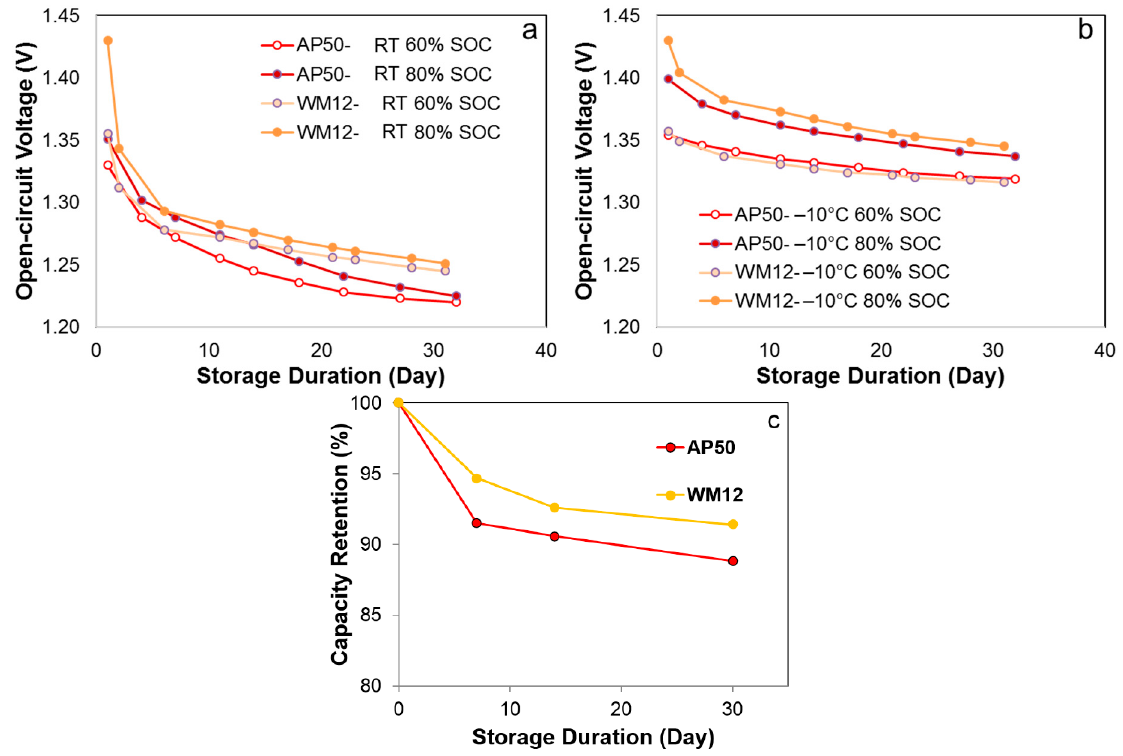
Figure 7. Self-discharge evaluations of Cell AP50 and Cell WM12 by the open-circuit voltages at both ( a ) room temperature (RT) and ( b ) − 10 °C at both 60% and 80% state-of-charge (SOC), and ( c ) by the capacity retention at RT and 80% SOC.